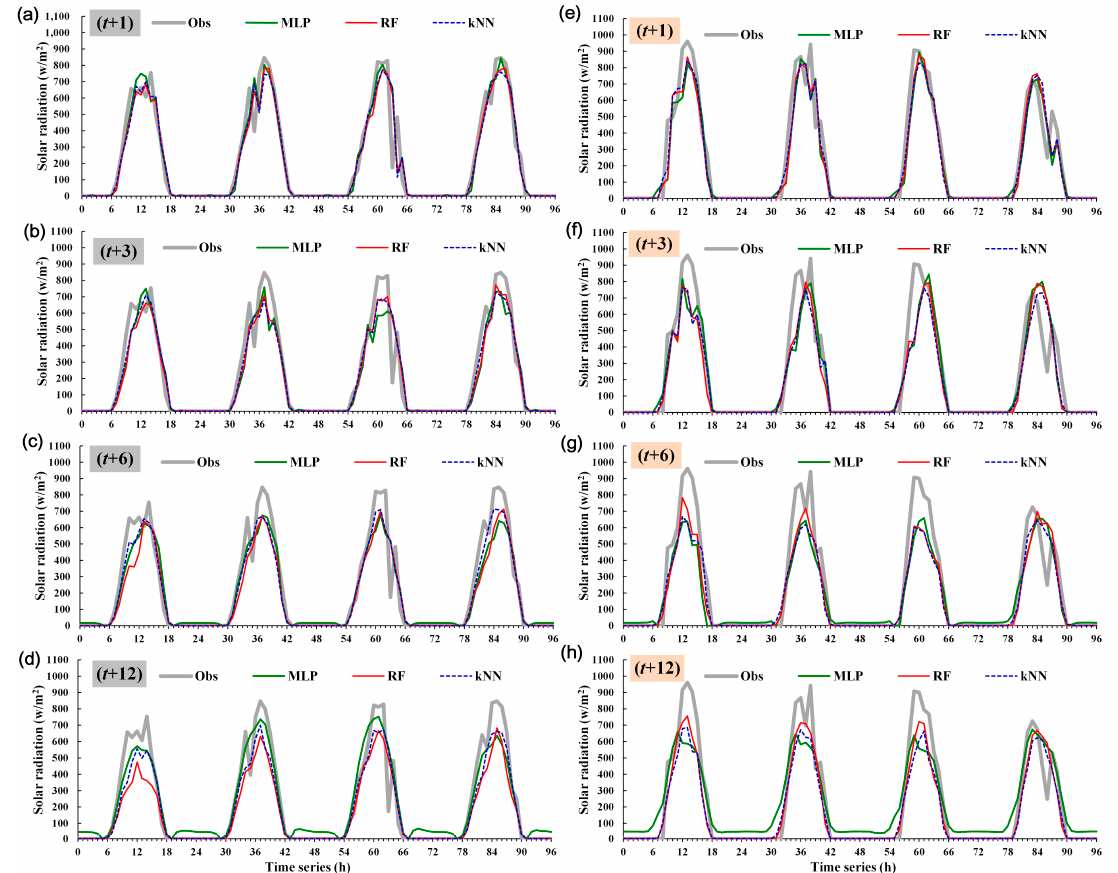
Figure 14. Hourly changes in the observed and predicted global irradiance with a β ′ of 33° for the four consecutive days starting from: ( a – d ) the summer solstice, and ( e – h ) the winter solstice.